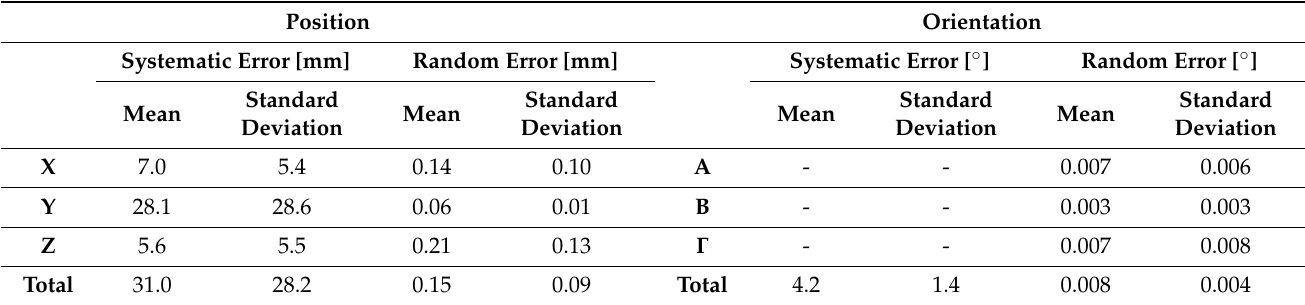
Table 1. Summary of the tracker measurement